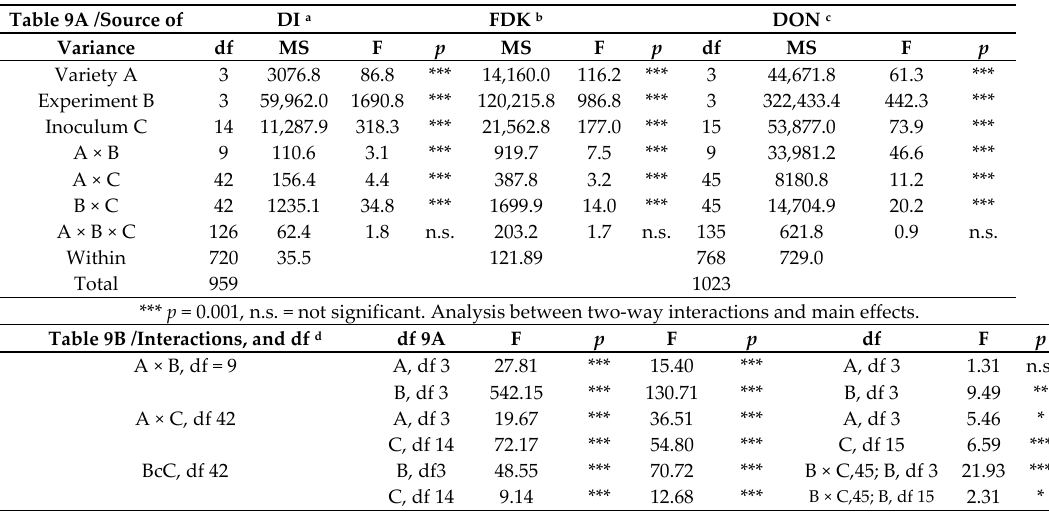
42 Within 720 35.5 729.0 Total 959 1023 Table 9B /Interactions, and df d